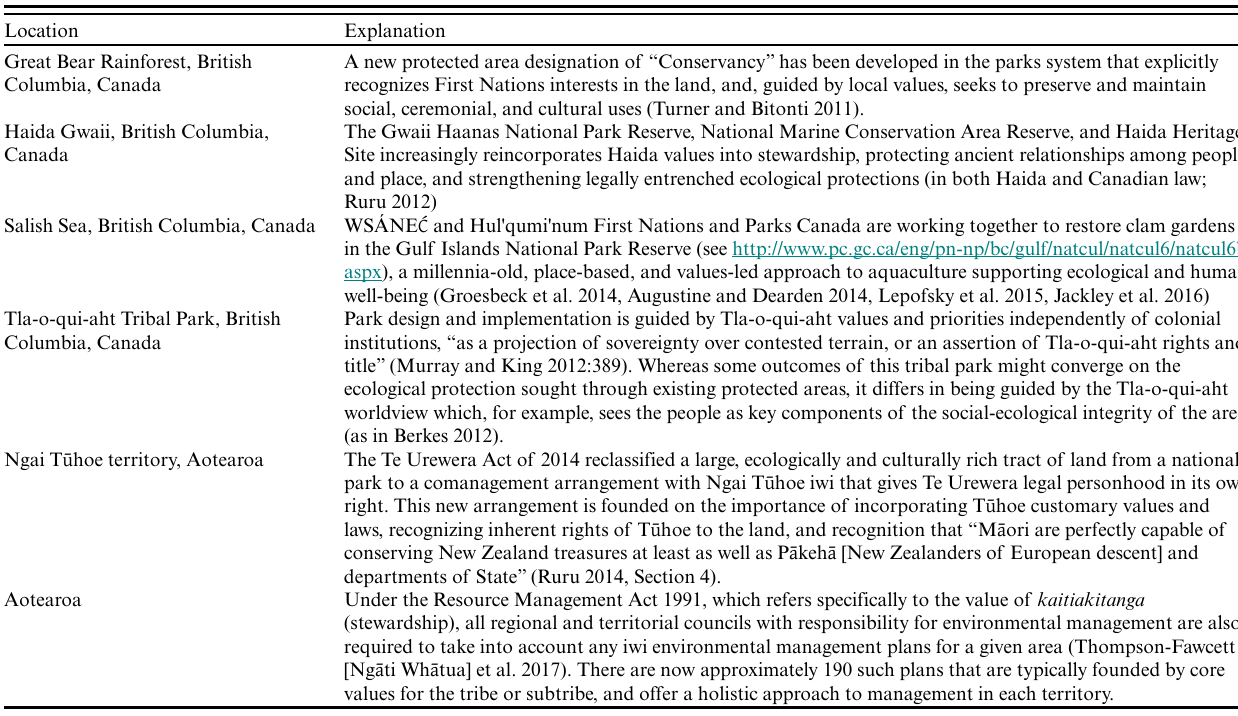
Table 1 . Examples of resurgent values-led management in Canada and Aotearoa (New Zealand)